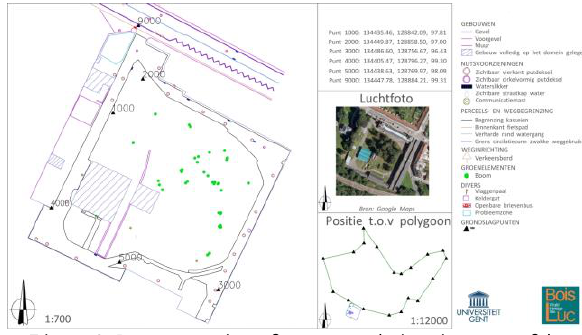
Figure 6: Representation of a measured situation map of the